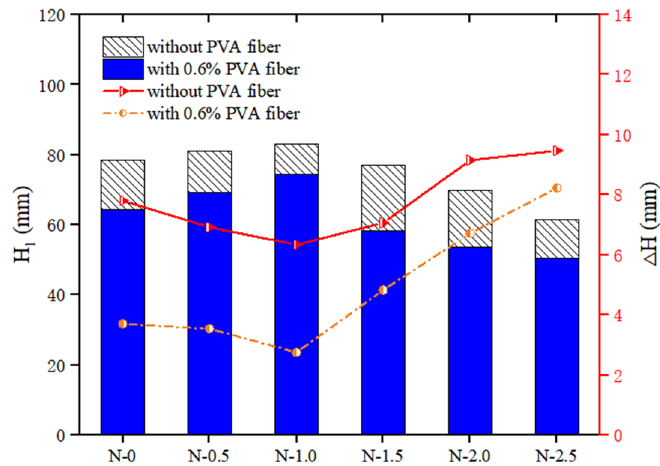
Figure 6. Effect of NS on thixotropy of geopolymer composites.